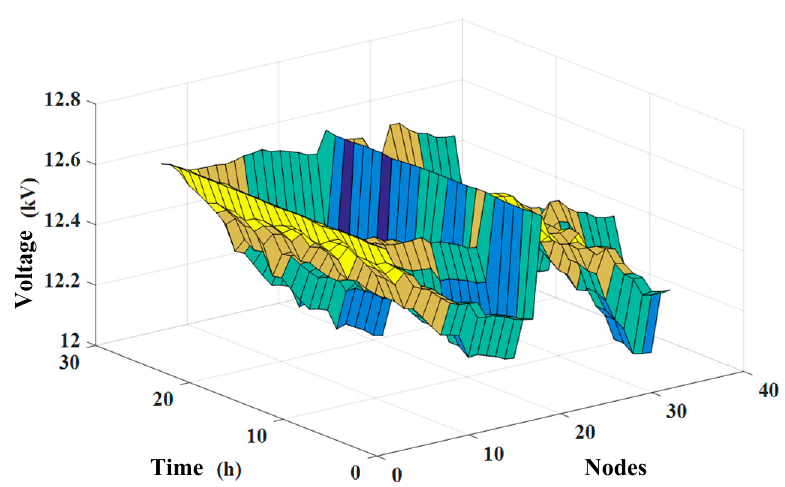
Figure 6. Node voltage level of AND.